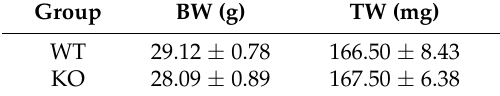
Table 1. Body and testicular tissues of wild type (WT) and knockout (KO) mice were weighted ( n = 8). BW—body weight; TW—testis weight; n = 8. All of the data were expressed as mean ± SEM. * p < 0.05.